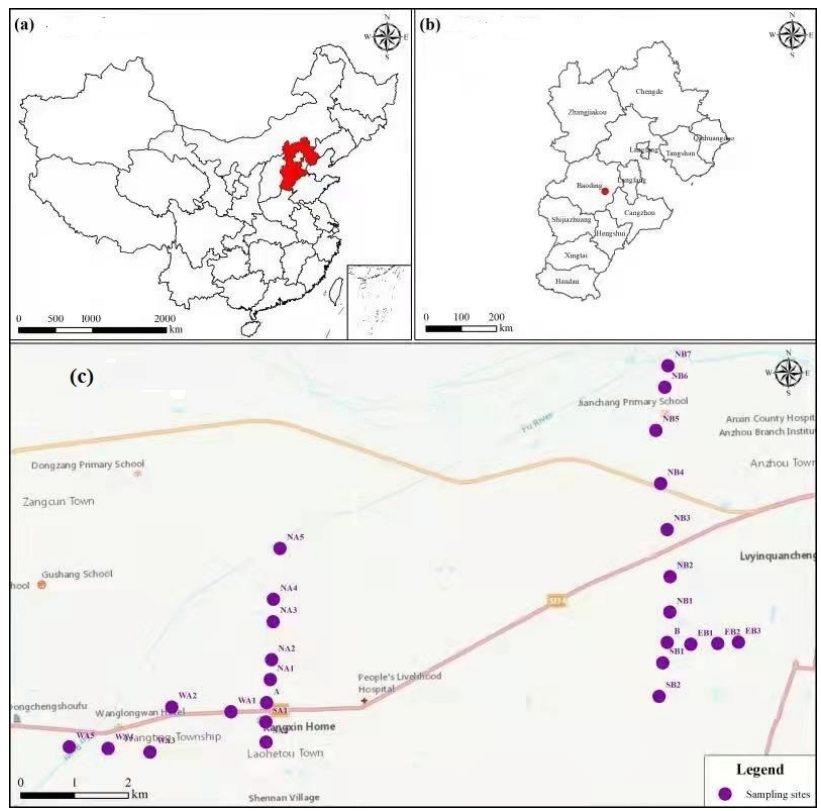
Figure 1. Sampling point location and distribution map. ( a ) Map of China; ( b ) Location map of Hebei Province in China and sampling site; ( c ) Distribution map of sampling sites.